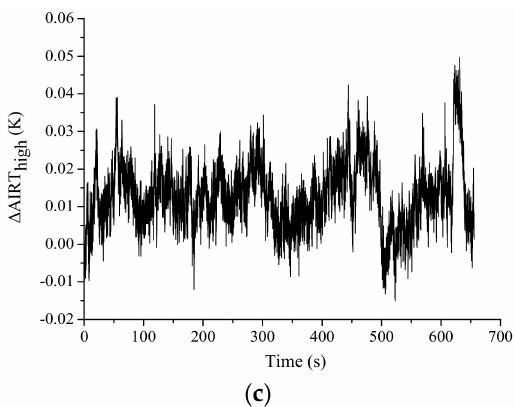
Figure 5. Results of decomposed ∆ AIRT using wavelet analysis in the cyclic loading process of sample HG-1: ( a ) ∆ AIRT low ; ( b ) ∆ AIRT mid ; ( c ) ∆ AIRT high .